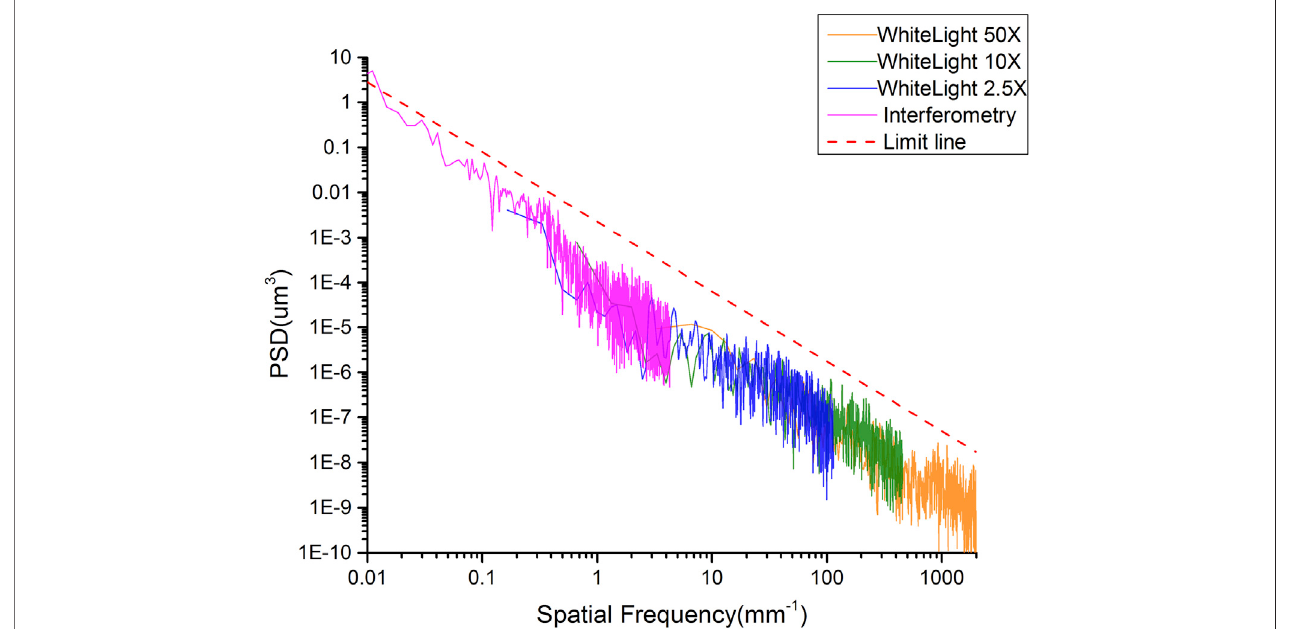
FIGURE 7 | Composite surface PSD function of M1 determined from different metrology instruments.